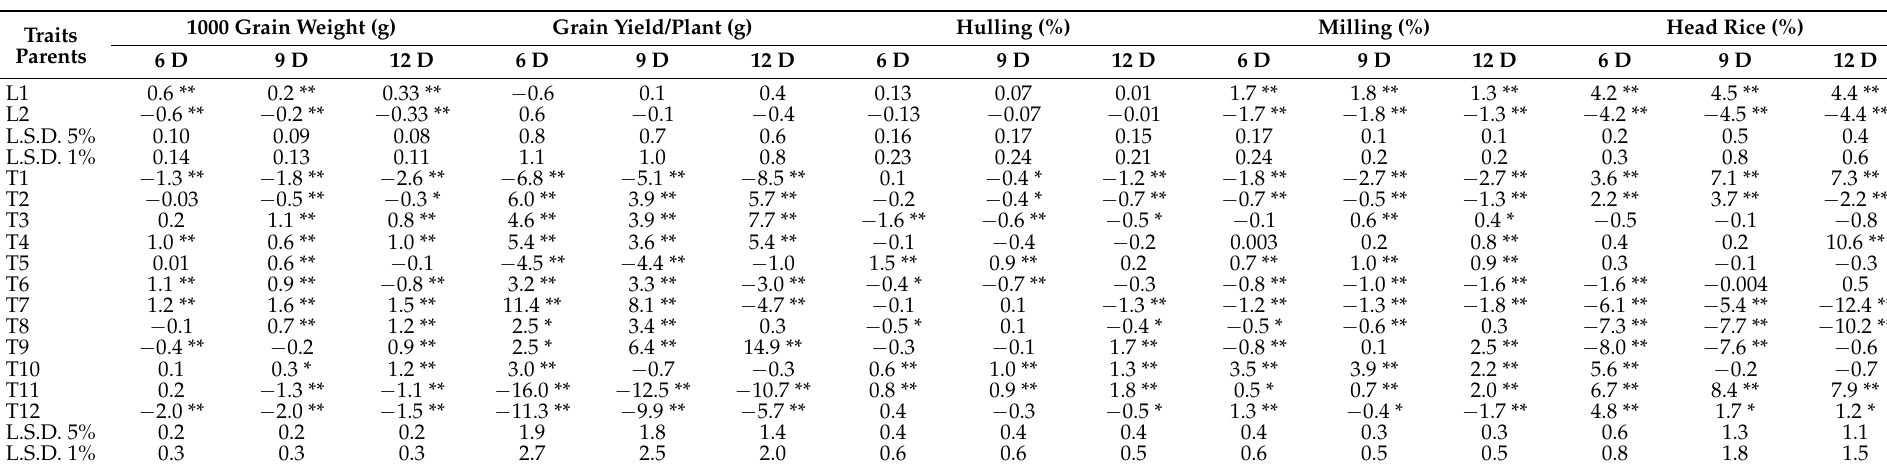
Table 7. General combining ability effects of the parental lines for 1000 grain weight, grain yield/plant and grain quality